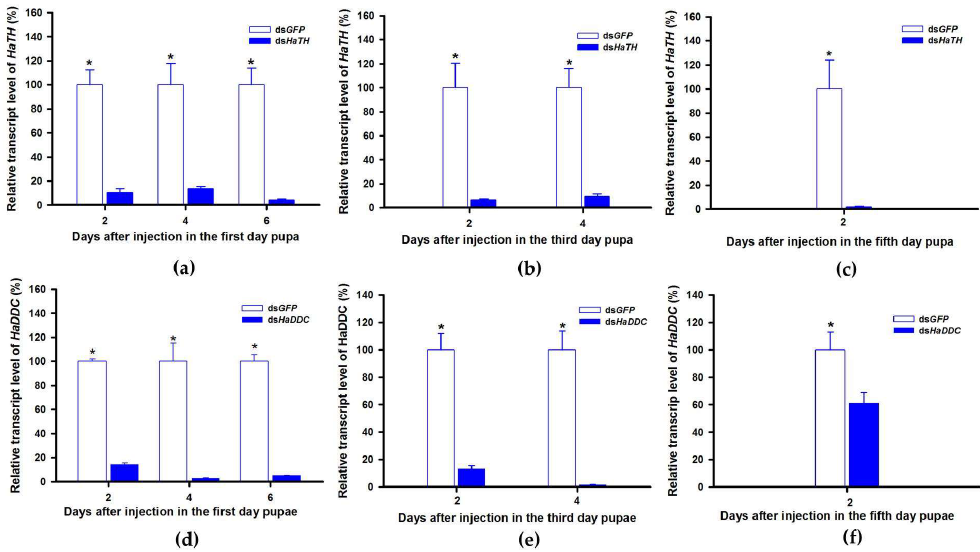
Figure 6. Time-dependent suppression of HaTH ( a , b , c ) and HaDDC ( d , e , f ) transcript in the 1-, 3-, and 5-day pupae of H. axyridis injected with ds HaTH and ds HaDDC at 300 ng/pupa or ds GFP at 300 ng/pupa as determined by RT-qPCR, respectively. The relative transcription levels (%) are presented as the mean and SE of three replicates with three insects. Notability analysis was based on SPSS (v. 22, IBM Corp. Armonk, NY, USA) followed by One-Way ANOVA ( p < 0.05) within the same time point. “*” indicates a significant difference in relative transcript level of HaTH and HaDDC between insect injected with ds HaTH (or ds HaDDC ) and ds GFP .